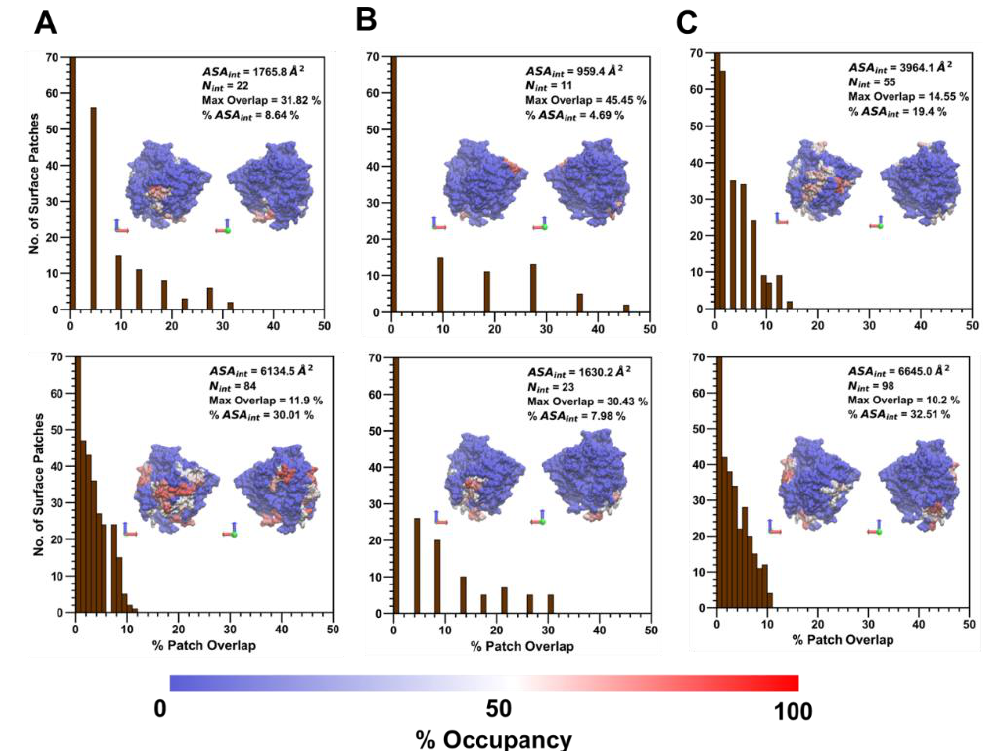
Figure 8. At high extension levels, the distribution of the number of contiguous surface patches that overlap with the collapsed averaged protein–polymer interface containing residues with >50% occupancy, at various overlap percentages, is shown for ( A ) PLGA/ID2S, ( B ) PEG/ID2S, and ( C ) PLGA-PEG/ID2S. Within each plot is the visualization of the collapsed interface, whereby red indicates max occupancy and blue indicates no occupancy. ASA int is the surface area of the collapsed prot–poly in- terface, N int is the total number of residues in the collapsed interface, and % ASA int is the percentage of ID2S surface area that is composed of the prot–poly collapsed interface. Max overlap value for each polymer/ID2S interface is also shown in each plot